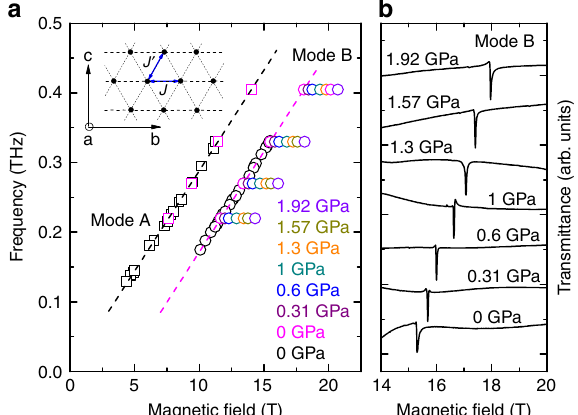
Fig. 1 Pressure dependence of ESR excitations in Cs 2 CuCl 4 ( T = 1.9 K, H || b ). a Frequency- fi eld diagrams of ESR excitations at different pressures. The data denoted in black are taken from ref. 6 ( T = 1.5 K; 0 GPa). Dashed lines correspond to the fi t results (see text for details). Source data are provided as a Source Data fi le. The inset shows a schematic picture of magnetic sites and exchange couplings in a triangular layer of Cs 2 CuCl 4 . b ESR spectra (mode B) taken at 330 GHz at different pressures (the spectra are offset